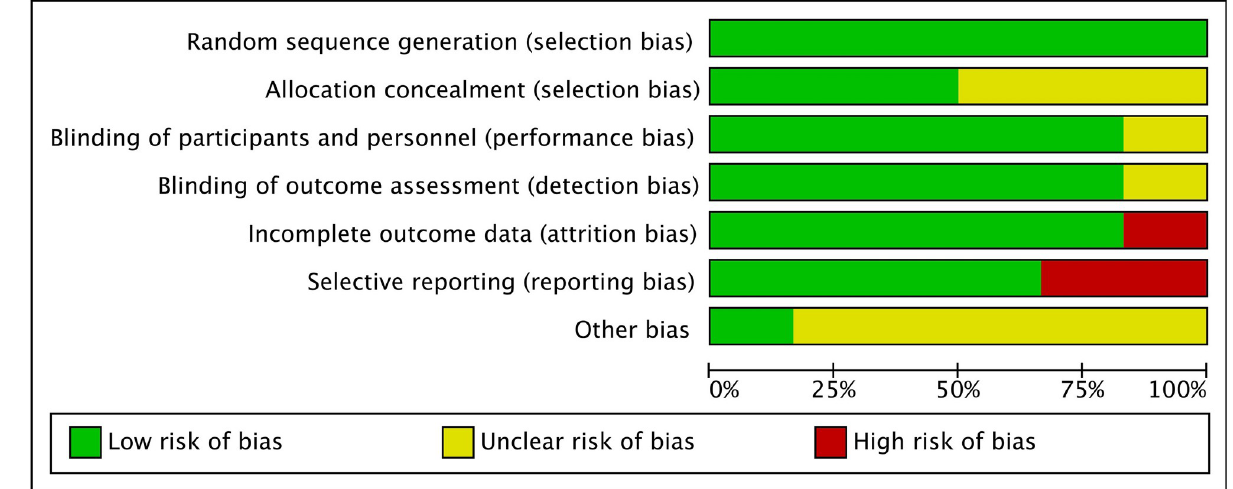
Fig 2. Risk of bias graph: Review authors’ judgments about each risk of bias item presented as percentages across all included studies.